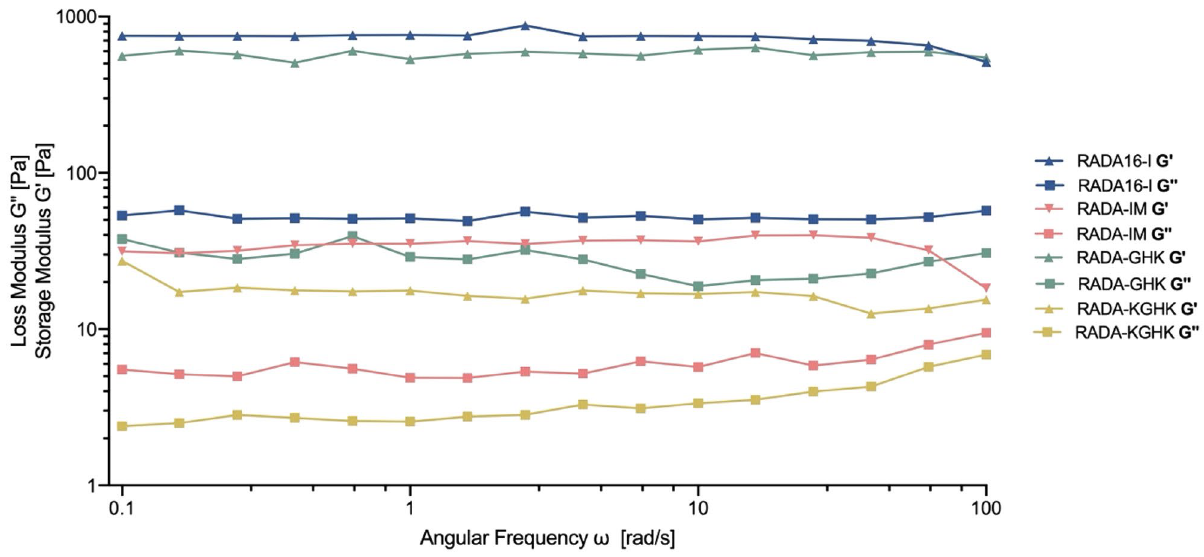
Figure 9. Mechanical characterization of hybrid peptides by dynamic frequency sweep test, at 1% concentration, ϒ = 1%, 37